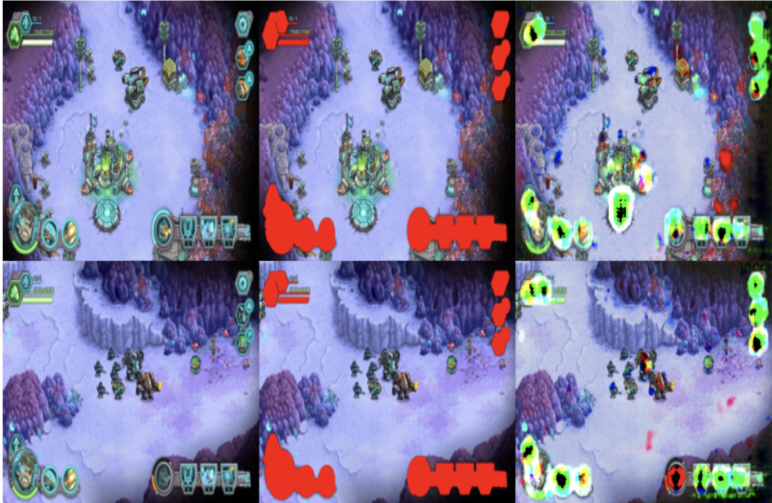
Figure 13. Result of applying the UI segmentation network trained with Kingdom Rush to Iron Marine. (Left: Original image, Middle: Ground truth, Right: Segmented